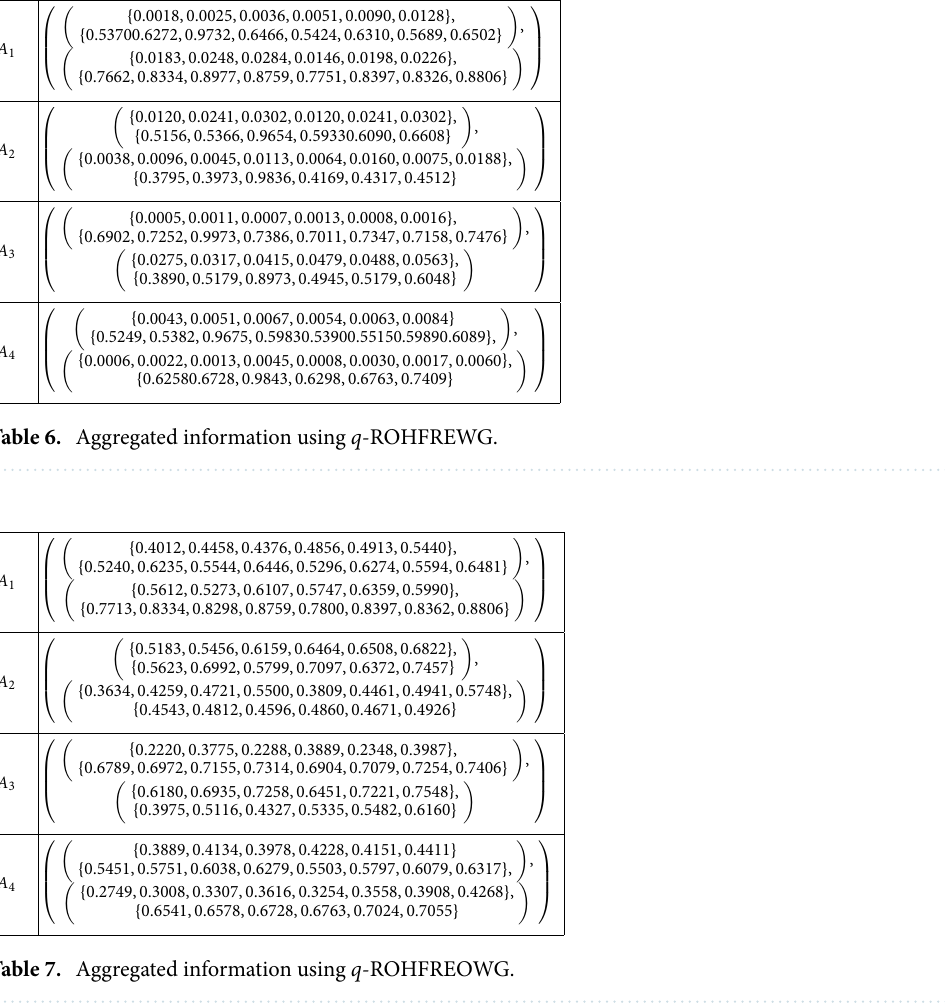
Comparison analysis